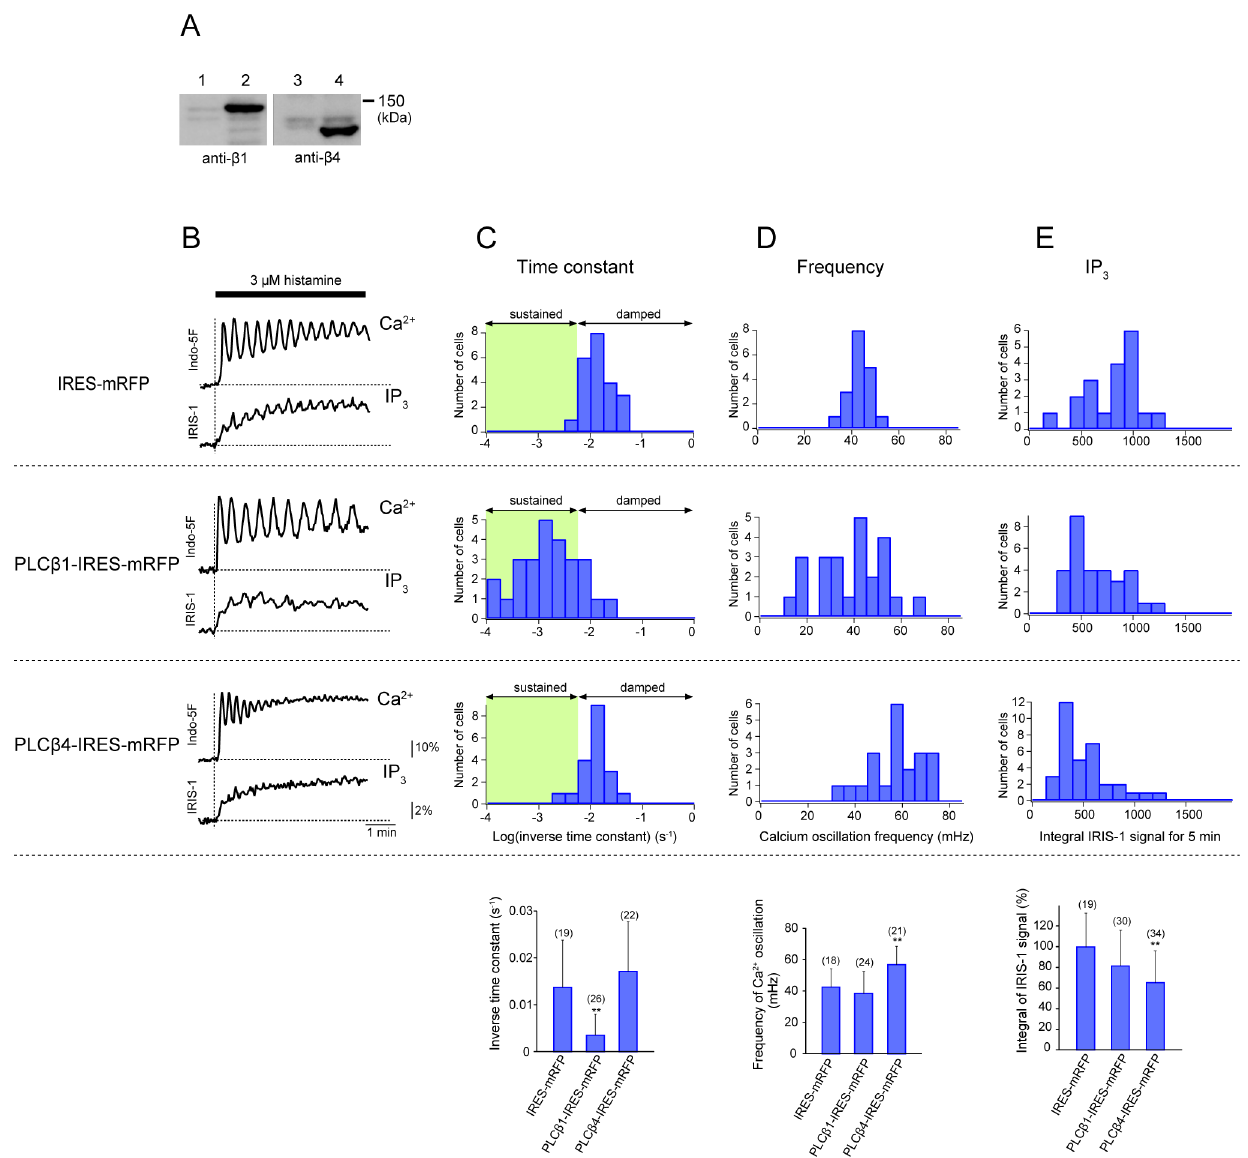
Figure 6. Effects of PLC- b 1 or PLC- b 4 overexpression on Ca 2 + and IP 3 dynamics evoked by histamine stimulation. (A) Western blotting analyses of cell lysates prepared from HeLa cells transfected with PLC- b 1-IRES-mRFP (lane 2) or PLC- b 4-IRES-mRFP (lane 4). Non-transfected cells were used as controls (lanes 1 and 3). (B) Representative traces of Indo-5F signal changes (F/F 0 ; top) and IRIS-1 signal changes ( D R/R 0 ; bottom) in transfected cells stimulated with 3 m M histamine. The plasmid DNAs used to transfect the cells are shown on the left. The horizontal broken lines indicate the baseline levels of IRIS-1 and Indo-5F signals. The vertical broken lines indicate the onsets of stimulation. (B–D) Histograms for the inverse time constants for exponential decay of the Ca 2 + oscillation amplitude (B), Ca 2 + oscillation frequencies (C), and integrated IP 3 signals (D) in cells expressing mRFP (top row), PLC- b 1 and mRFP (second row), and PLC- b 4 and mRFP (third row). The means 6 SD are shown at the bottom. The numbers of cells measured are shown in parentheses. Statistical analyses were performed by one-way ANOVA followed by Scheffe’s multiple comparison test. **P , 0.01, vs. the values in IRES-mRFP transfected cells.